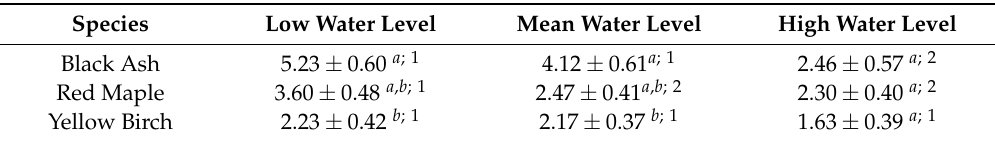
Figure 2. Observed (points) and modeled (lines) daily mean sap flux (m 3 m − 2 day − 1 ) by square-root transformed daylight-normalized vapor-pressure deficit (kPa) within relative water level bins. Shaded regions show 95% confidence intervals. Modeled daily mean sap flux and shaded regions represent species response to D z at the mean relative water level for each species and water level bin as fit from a single complete model. Table 4. Marginal mean slope estimates and standard errors of sap flux (m 3 m − 2 day − 1 ) response to square-root transformed daylight-normalized vapor pressure deficit (kPa).